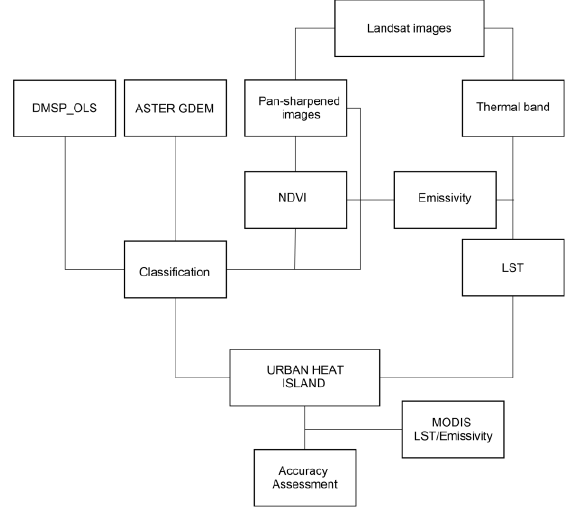
Figure 2. Flowchart of the UHI effect determination procedure